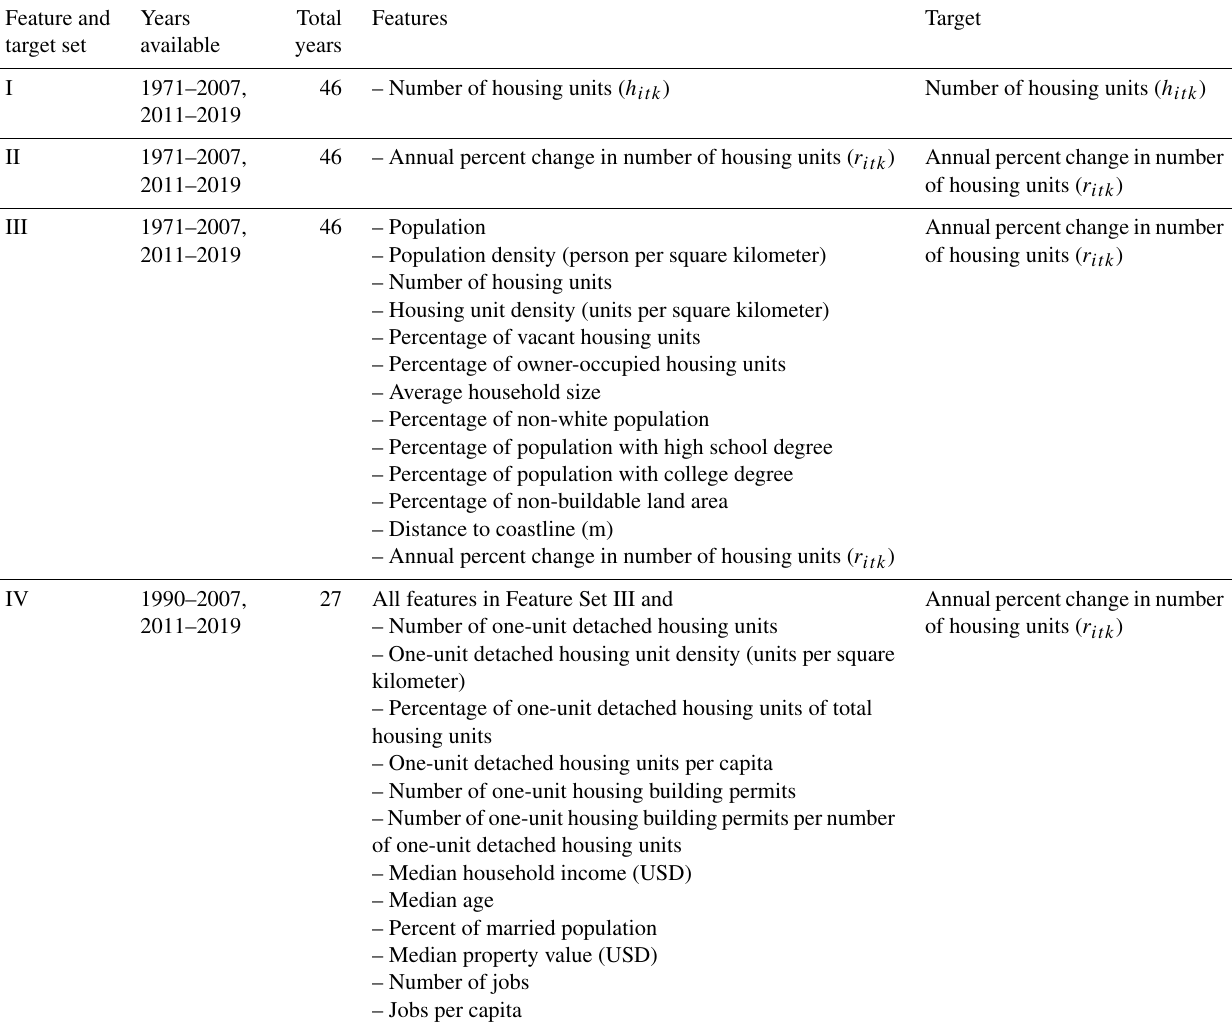
Table 3. Feature and target